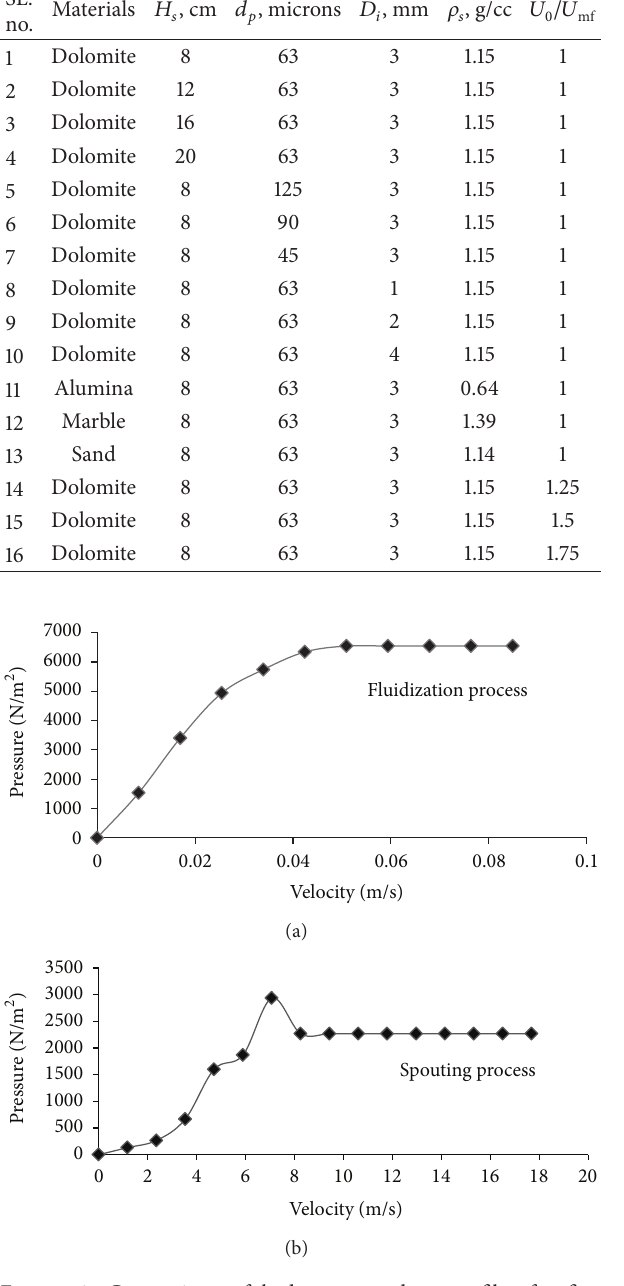
Table 2: Scope of experiment for fine particles in spouting process. SL.